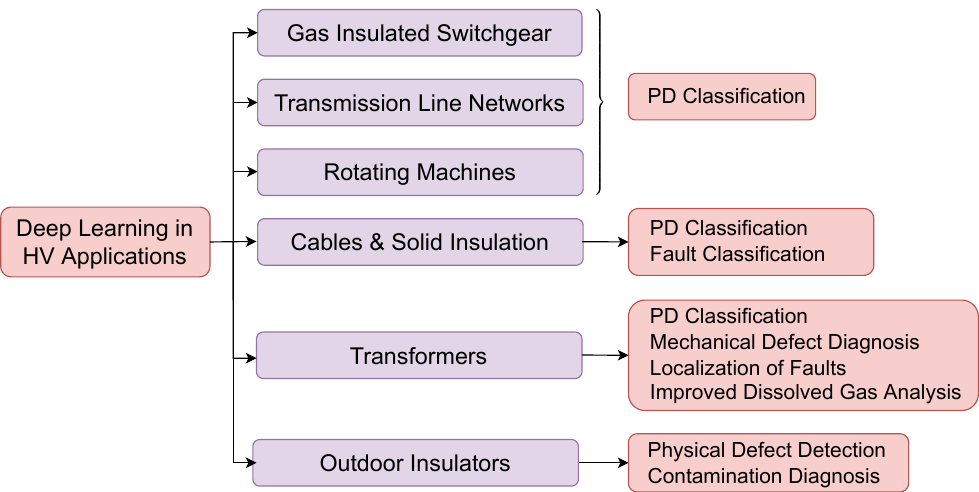
Figure 1. An overview of the topics covered in this review paper.